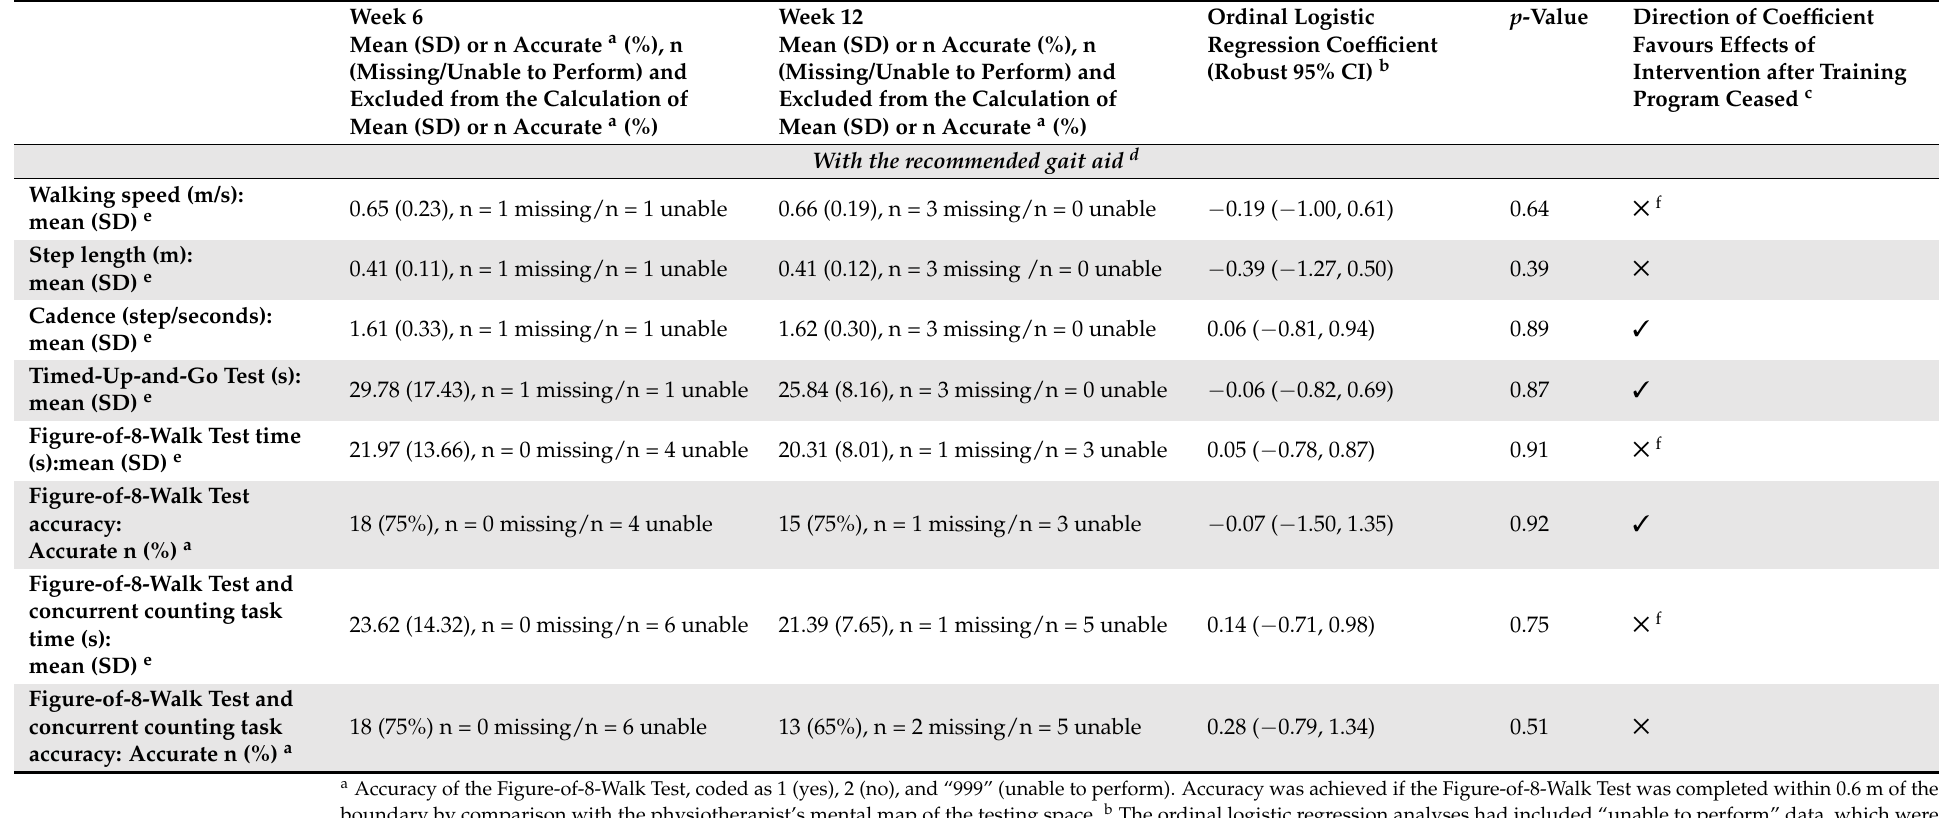
p -Value Direction of Coefficient Ordinal Logistic Regression Coefficient Favours Effects of (Robust 95% CI) b Intervention after Training Program Ceased c